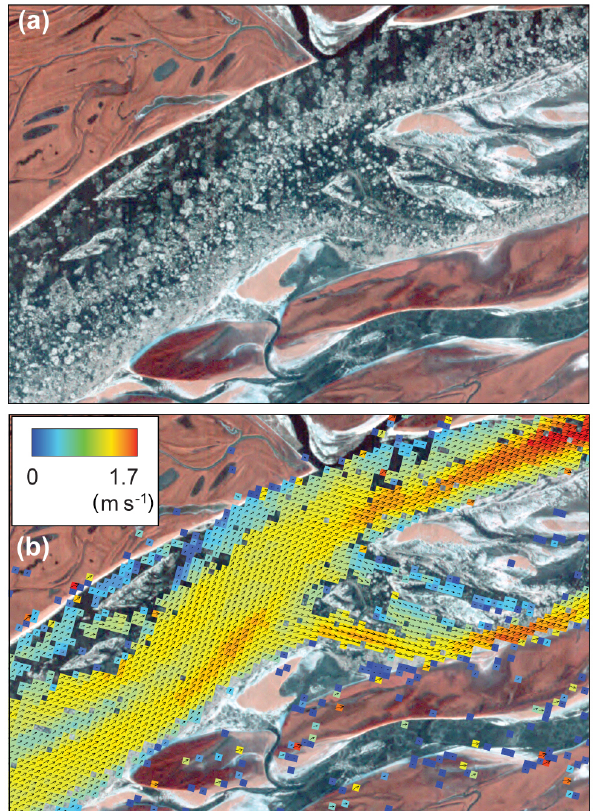
Figure 6. Detailed zoom-in of a section of Fig. 5 (see small rectan- gle in Fig. 5). (a) Planet cubesat image from 1 November 2016, and (b) the original matched surface velocities after the constraint of the correlation coefficient. The grid spacing of vectors is 75m. Match- ing results are given with the speed colour-coded and with velocity vectors superimposed. The maximum speed was 1.7ms − 1 .